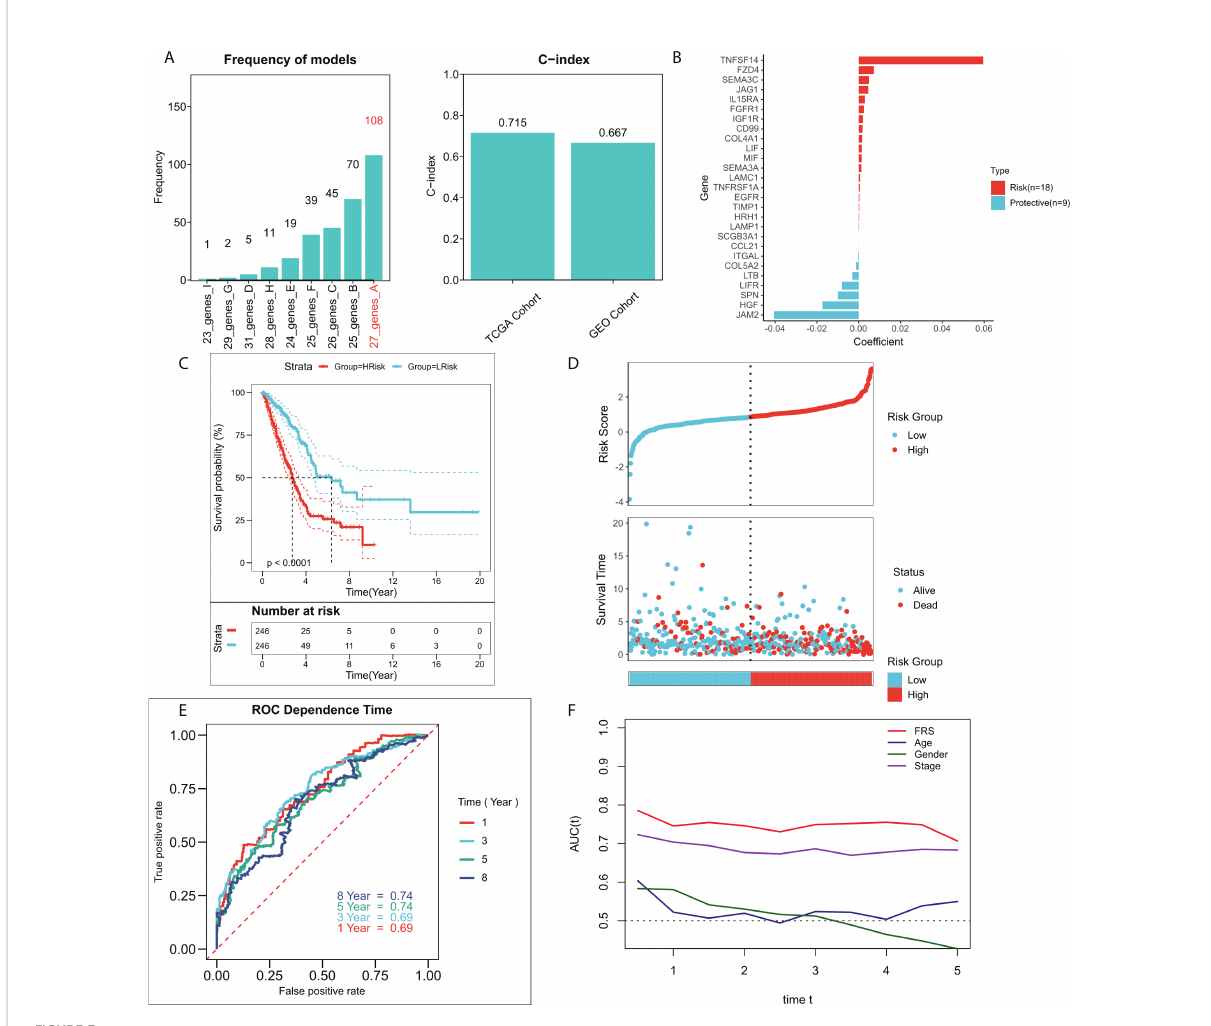
FIGURE 3 Construction of the FRG-related risk model. (A) Screening for the best LASSO model. Left panel: frequency of different gene combinations in the LASSO Cox regression model; Right panel: C-index of the best model in both TCGA and GEO cohorts; (B) LASSO coef fi cients for the 27 model genes; (C) KM survival curves for the high-FRS and low-FRS groups in the TCGA cohort; (D) Survival status and FRS of patients in TCGA cohort; (E) 1-, 3-, 5-, and 8-year ROC curves for FRS in TCGA cohort; (F) tROC curves for FRS and clinical characteristics in TCGA